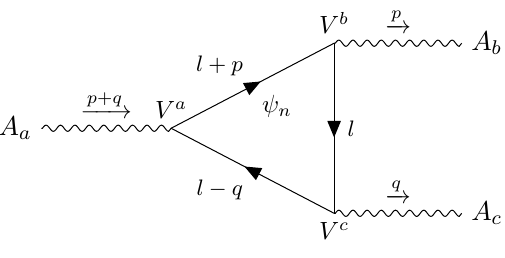
Figure 2 . The AAA diagram in 5d, with external momenta and polarizations